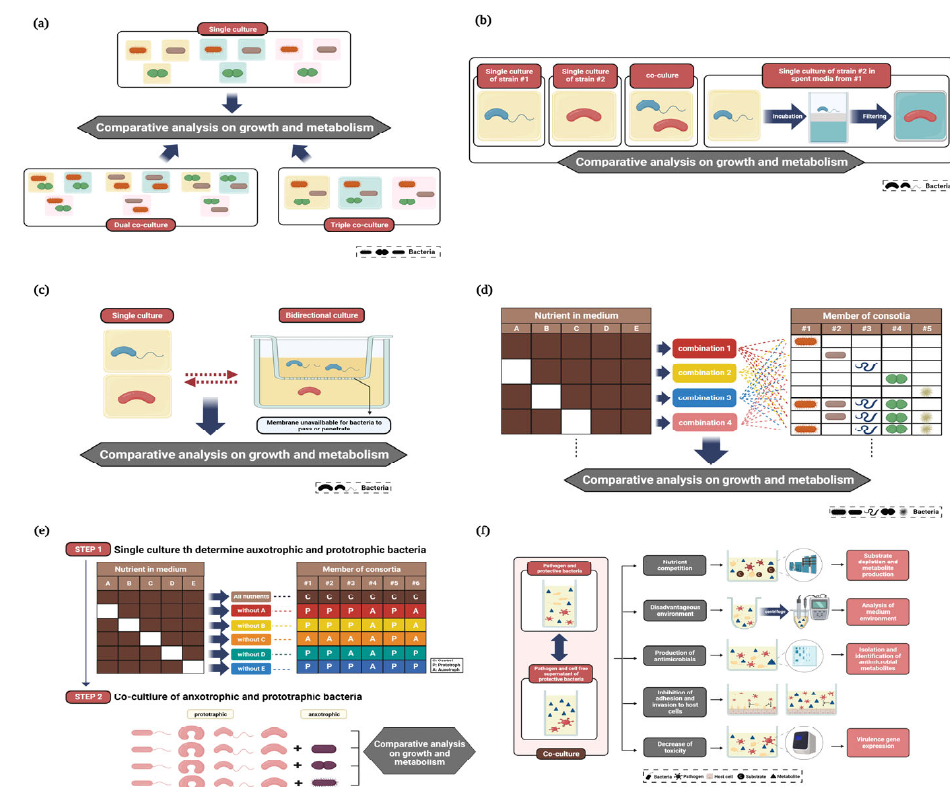
Figure 1. Major methods for singular and mixed culture of model strains of gut microbiota (created with www.biorender.com (accessed on 22 February 2023)). ( a ) Comparative analysis of the singular and co-culture of bacteria under various environments by differentiating the growth determinant factors ( b ) Assessment of the one-way relationship of trophic level by unidirectional culture using spent medium ( c ) Assessment of the two-way relationship of trophic level by bidirectional culture ( d ) Analysis of growth and metabolism pattern in accordance with complex combination of nutri- ents and members of bacterial consortia ( e ) Induction of syntrophic growth by the cross-feeding during the co-culture of auxotrophics and prototrophics ( f ) Pathogen control strategies based on bacterial